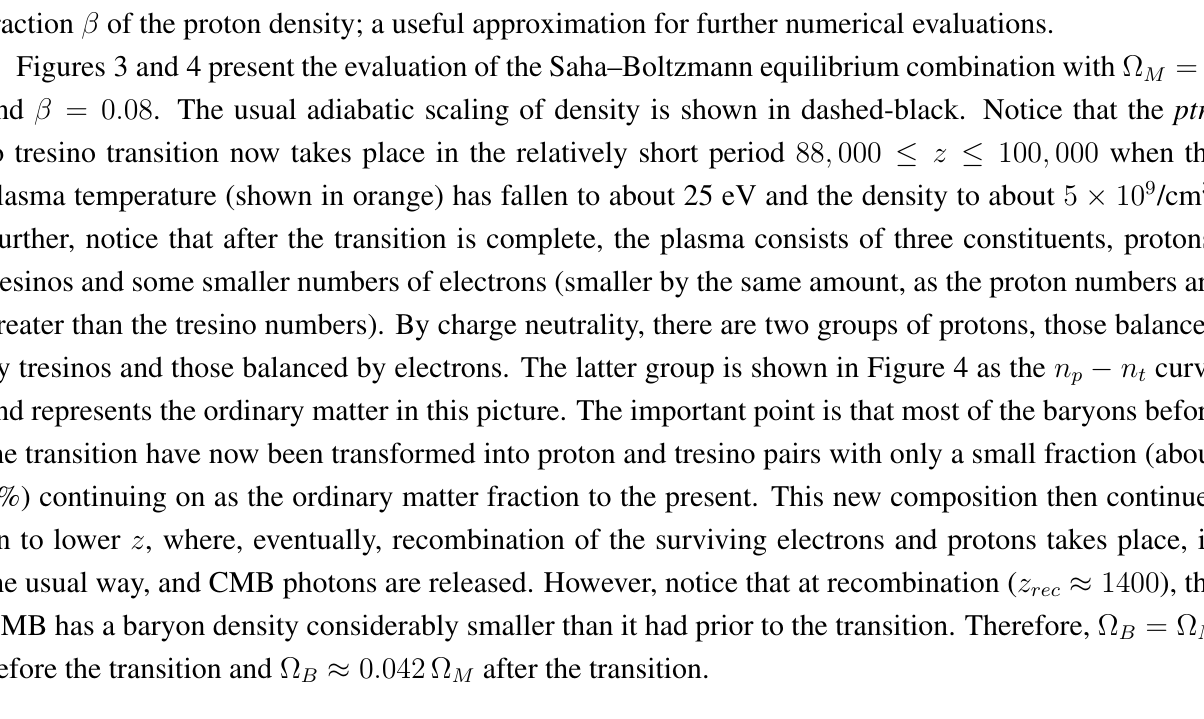
Figure 3. Numerical evaluation of the equilibrium Saha–Boltzmann tresino combination displaying the proton density n in blue, the tresino density n in red, the electron density p t n = 1 , h = 0 . 71 in green, the temperature T ◦ K in orange , and n in dashed-black, with Ω e B M and β = 0 . 08 (see text). Note: the tresino and electron densities have been reduced by 10% for graphical clarity. The inset displays the (earlier) α -tresino generation in dashed red from 4 He in purple (see Section 4.1 and Appendix